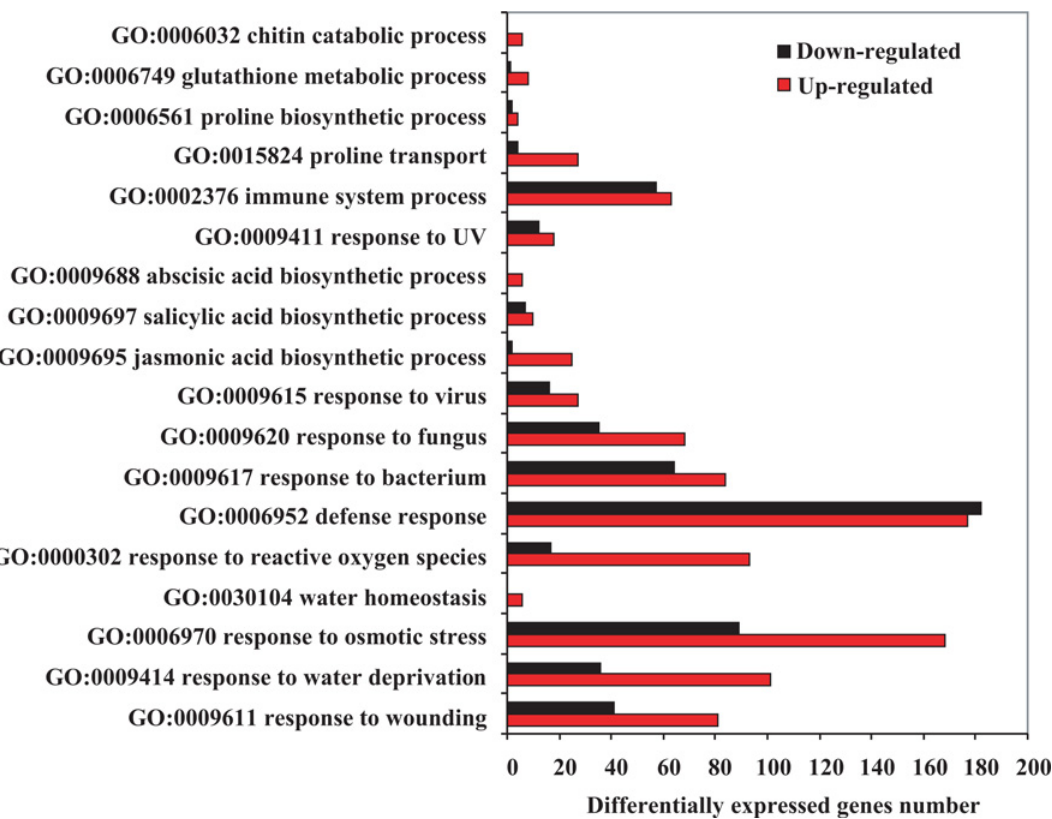
Fig 6. The GO term assignments for the DEGs related to the stress response under the overgrazing and non-grazing conditions. The red bars represent the upregulated DEGs, the black bars represent the downregulated